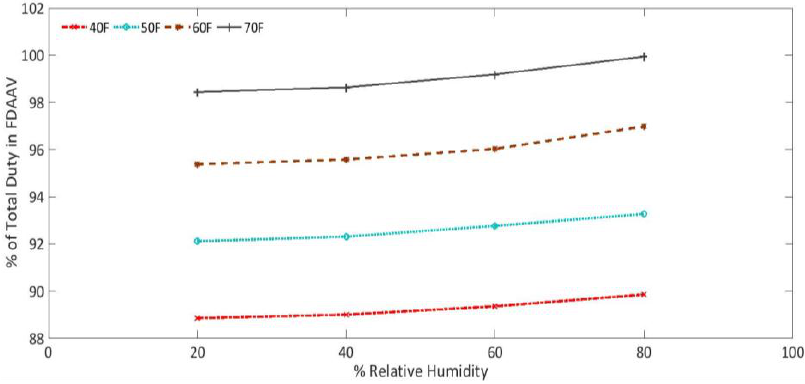
Figure 15. Effect of humidity on fan forced vaporizer performance [18].